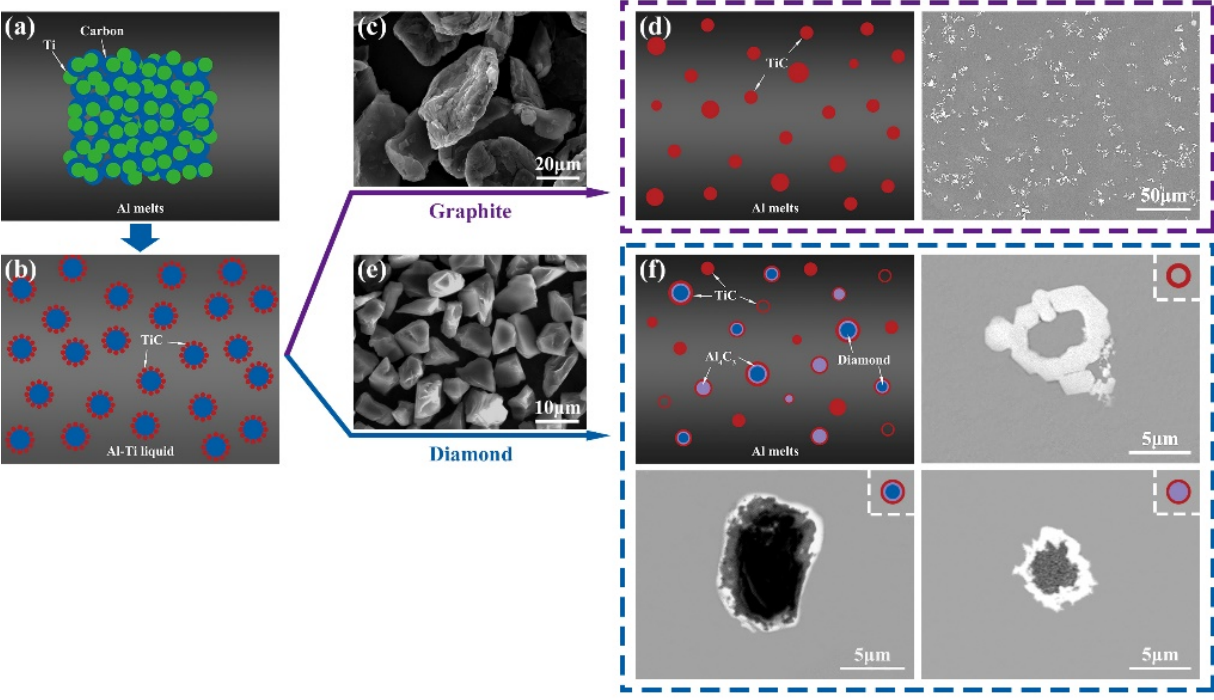
Figure 15. Synthesis processes of TiC after adding the Ti-C mixture into Al melts: ( a ) adding Ti-C mixture into Al melt, ( b ) TiC synthesized on the surface of carbon sources, ( c ) the used graphite, ( d ) the formed TiC clusters, ( e ) the used diamond, and ( f ) the formed TiC and core–shell particles.